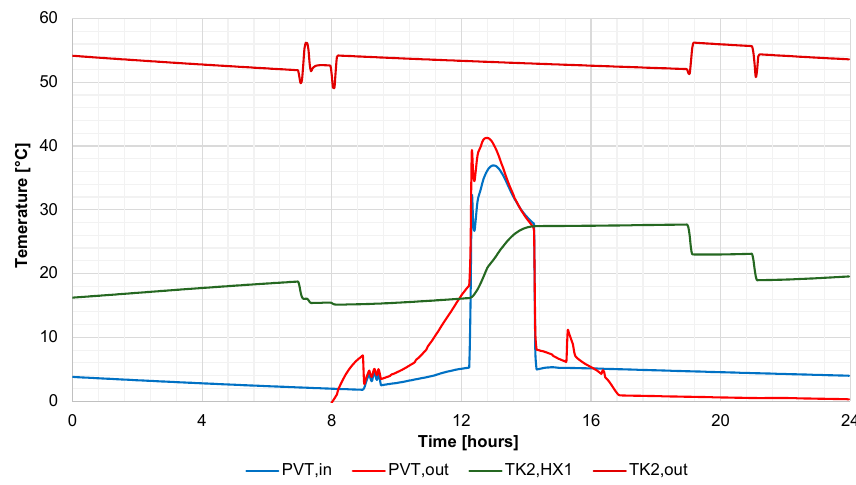
Figure 6. Main temperatures of PVT and TK2, daily analysis, winter day.